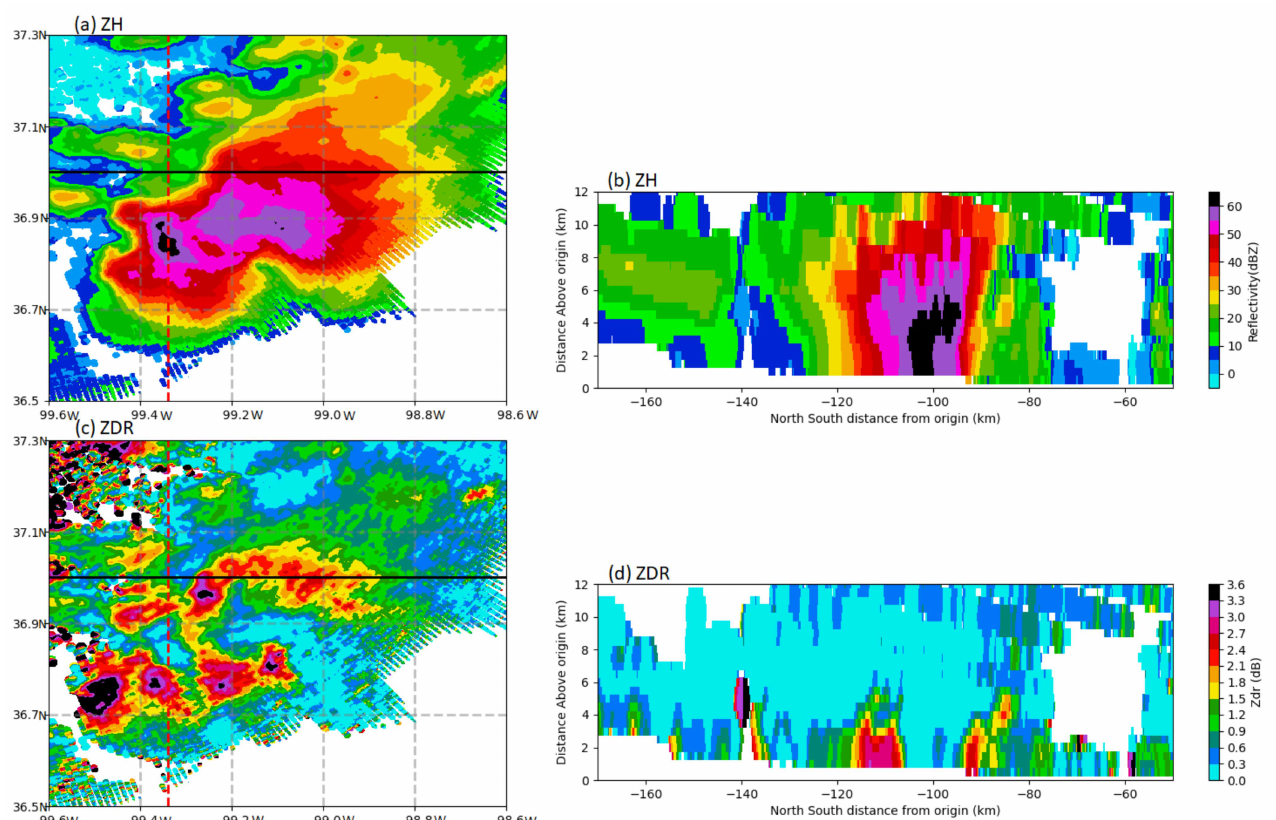
Figure 12. ( a ) Z H and ( c ) Z DR at 1 km height collected by KDDC radar at 2321 UTC 29 May 2018. Vertical cross-section of ( b ) Z H and ( d ) Z DR along the longitude of 99.34 ◦